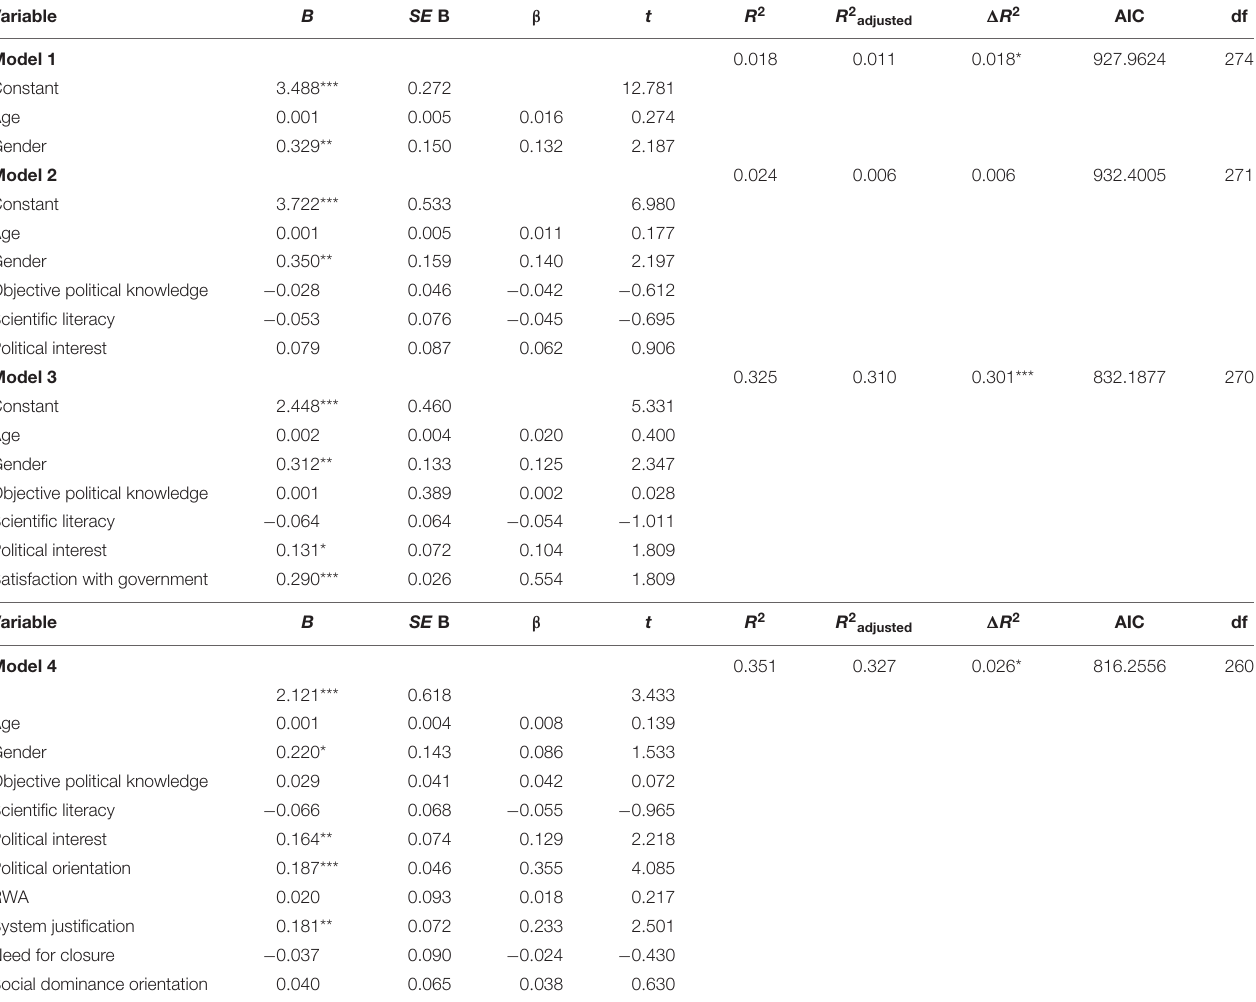
TABLE 8 | Hierarchical regression results for belief in pro-government real